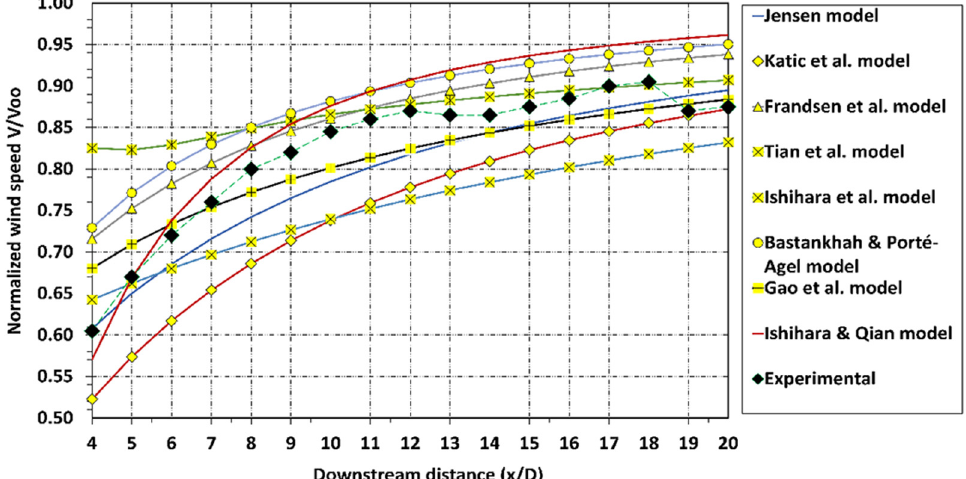
Fig. 7. Experimental and calculated wake development for upstream wind speed value equal to